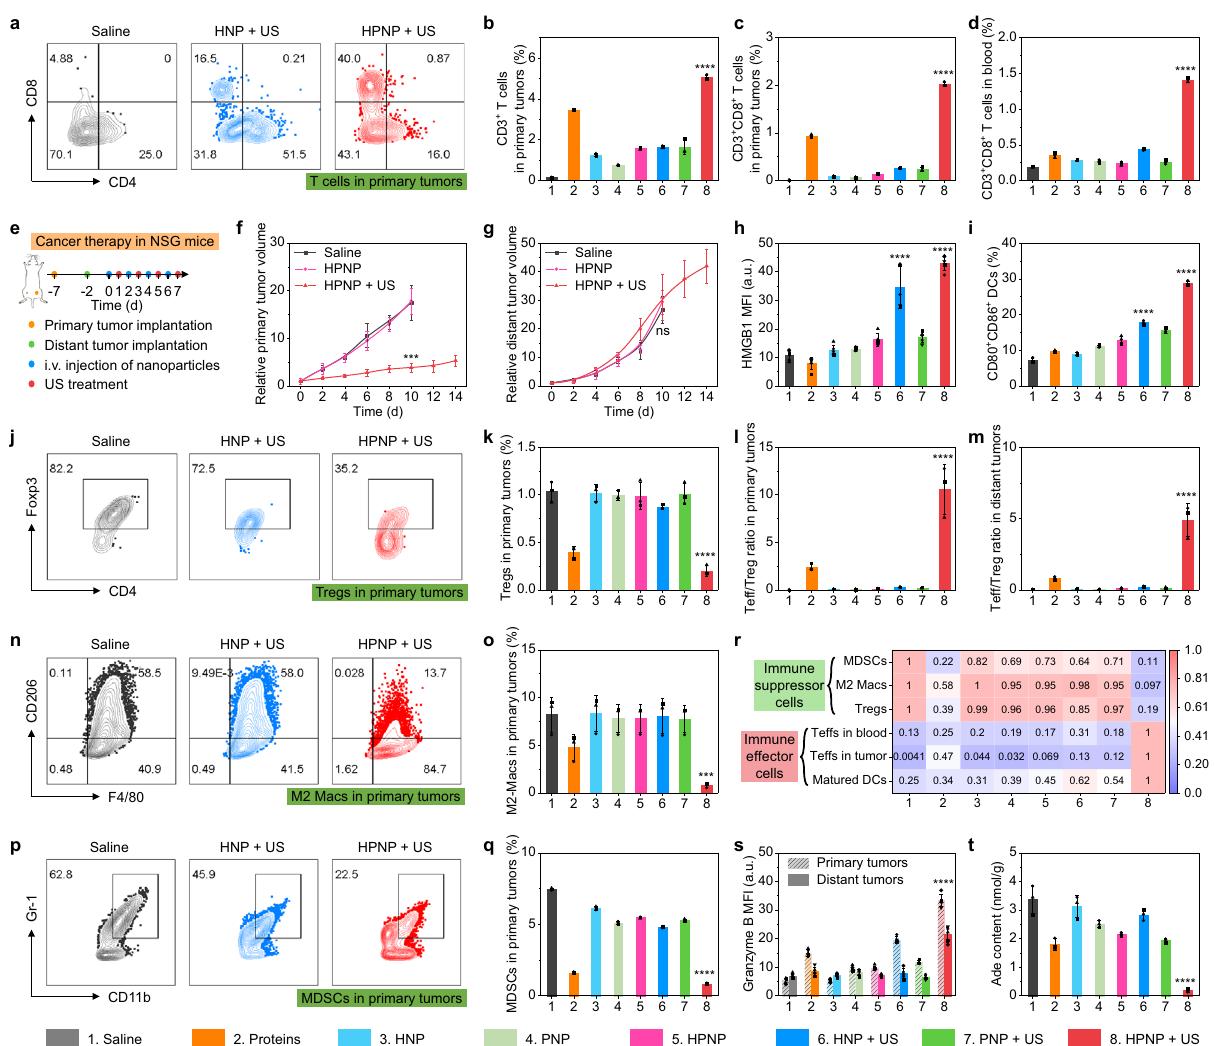
Fig. 5 In vivo mechanistic study of nano-immunocomplex-mediated activatable sono-metabolic checkpoint trimodal cancer therapy. a Flow cytometry assay of tumor-in fi ltrating T lymphocytes (CD8 + and CD4 + ) and quanti fi cation of CD3 + T cells ( b ) and CD3 + CD8 + Teffs ( c ) in primary tumors ( n = 3). 8 versus other groups in b and c : p <0.0001. d Flow cytometry quanti fi cation of CD3 + CD8 + Teffs in blood ( n = 3). 8 versus other groups: p < 0.0001. e Schematic illustration of the schedule for implantation and treatment of 4T1 tumor-bearing immunode fi cient NSG mice. Growth curves of primary tumors ( f ) and distant tumors ( g ) after different treatments ( n = 5). HPNP + US versus saline in f : p = 0.0002; HPNP + US versus saline in g : not signi fi cant (ns). h Quanti fi cation of HMGB1 expression in primary tumors ( n = 5). 8 versus 5: p <0.0001; 6 versus 3: p < 0.0001. i Flow cytometry quanti fi cation of matured DCs (CD80 + CD86 + ) in TDLNs ( n = 3). 8 versus 5: p <0.0001; 6 versus 3: p <0.0001. Flow cytometry assay ( j ) and quanti fi cation ( k ) of CD4 + Foxp3 + Tregs in primary tumors ( n = 3). 8 versus 1: p <0.0001. Quanti fi cation of Teff/Treg ratio in primary ( l ) and distant ( m ) tumors ( n = 3). 8 versus other groups